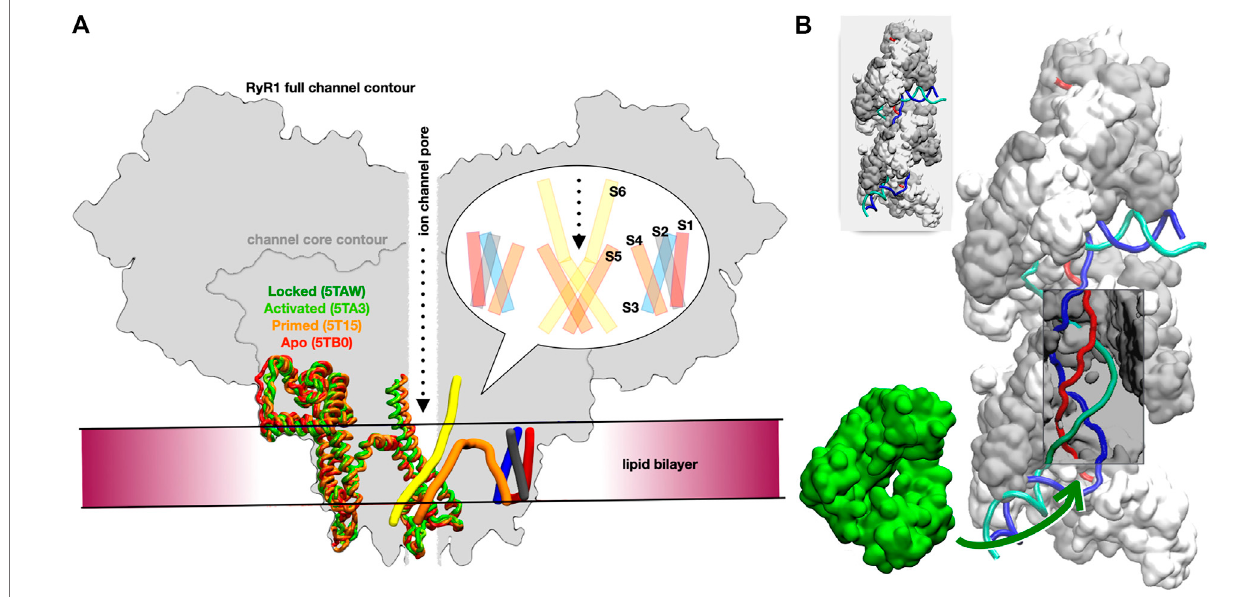
FIGURE1 | Overview of thetwo studied systems. (A) Schematic cross-sectional viewof thefullRyR channel model. The approximate location of the lipid bilayer is drawn, as is the central ion channel pore. On the left side of the schematic, the helical sections for a transmembrane domain monomer for each of the four states locked (darkgreen), activated (light green), primed (orange), and apo (red) are overlaid tohighlight the conformationalchangesin this region. On the right side, the pattern ofthe six transmembrane helices is shown in cylindrical form: S1 in red, S2 in grey, S3 in blue, S4 and S5 in orange, and S6 in yellow. A bubble inset shows a schematic cross-section of the transmembrane domain, as typically found in the literature, for reference. (B) Two turns of the RecA* fi lament with three bound DNA strands; RecA proteinsarerepresented alternativelyinwhiteandgrey(surface);theDNAstrands areschematicallyrepresentedinred,blueandcyan; thesection thatisincorporated in the fi lamentformaD-loop,wherethebluestrandhasexchangeditspairingpartnerfromthecyantotheredstrand;awindowhasbeenopenedinthe fi lamenttovisualize the otherwise hidden D-loop (a complete fi lamentis represented in the top left insert). The DinB DNA polymerase isrepresented ingreen surface; the green arrow points to the region of the fi lament where DinB binds to the DNA strands and RecA monomers in order to start elongating the red DNA